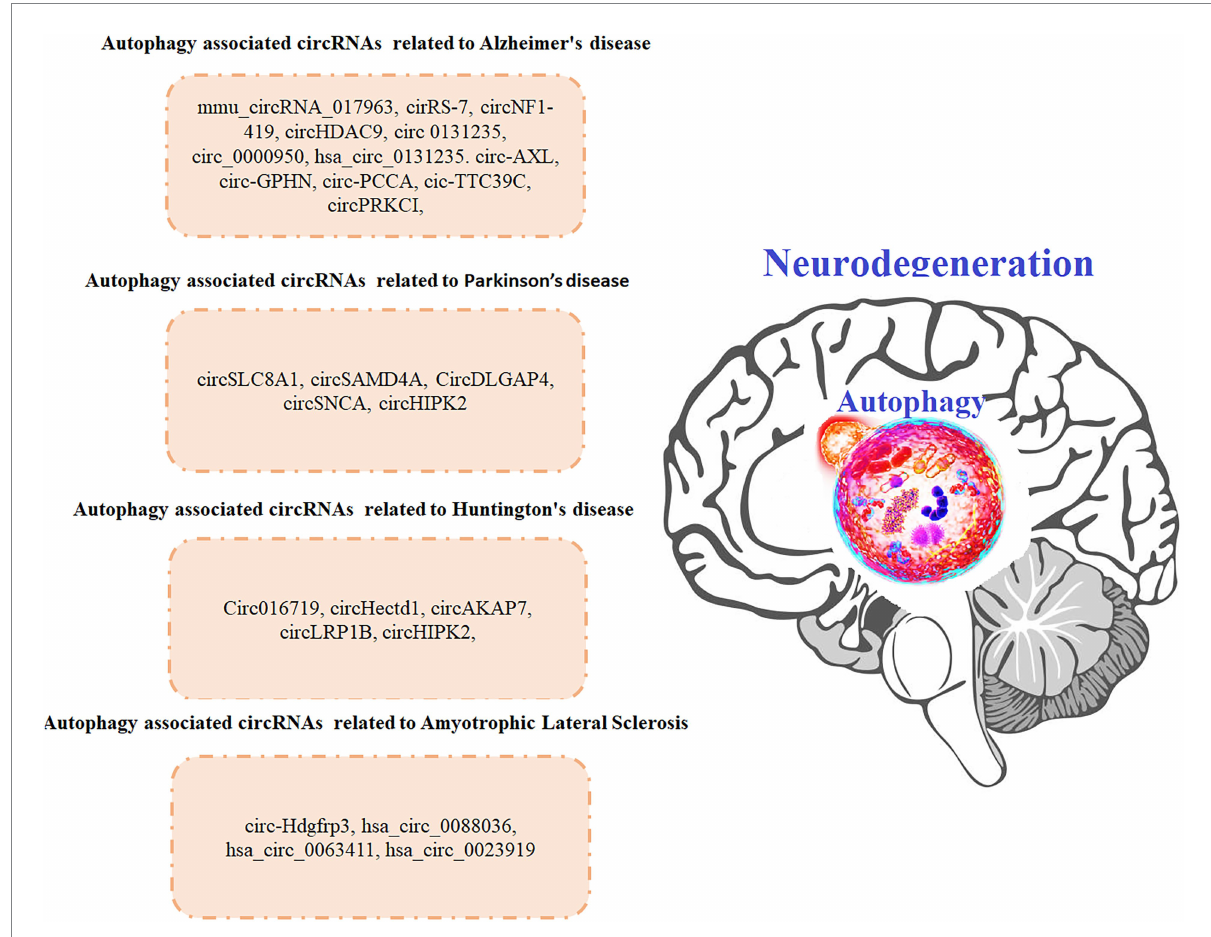
FIGURE 3 Autophagy associated circRNAs involved in neurodegenerative